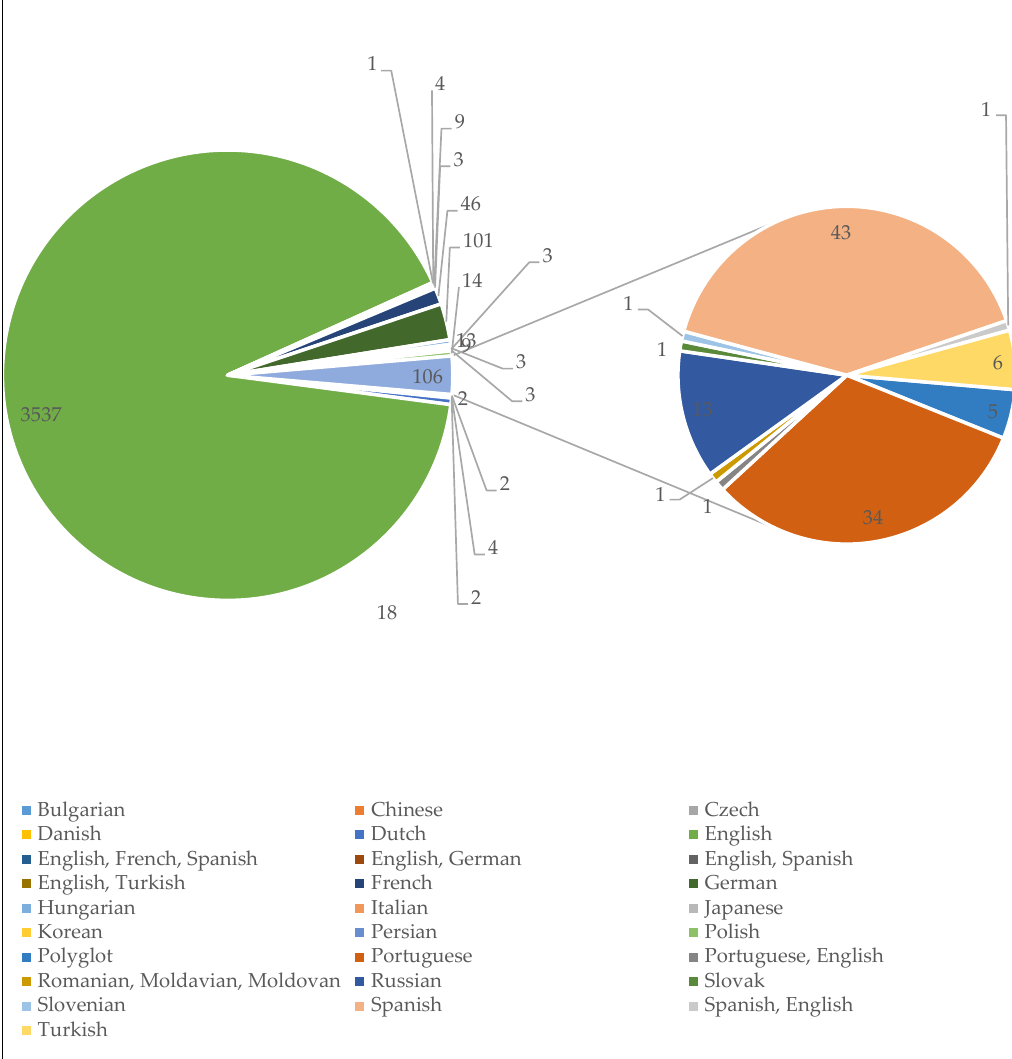
Figure 2. Publication language distribution of MAP output research from 1911 to 2019. Language Frequency % of 3889. Bulgarian (0.05%), Chinese (0.05%), Czech (0.10%), Danish (0.05%), Dutch (0.46%), English (90.95%), English, French, Spanish (0.03%), English, German (0.10%), English, Spanish (0.23%), English, Turkish (0.08%), French (1.18%), German (2.60%), Hungarian (0.33%), Italian (0.23%), Japanese (0.08%), Korean (0.08%), Persian (0.08%), Polish (0.36%), Polyglot (0.13%), Portuguese (0.87%), Portuguese, English (0.03%), Romanian, Moldavian, Moldovan (0.03%), Russian (0.33%), Slovak (0.03%), Slovenian (0.03%), Spanish (1.11%), Spanish, English (0.03%), and Turkish (0.15%).